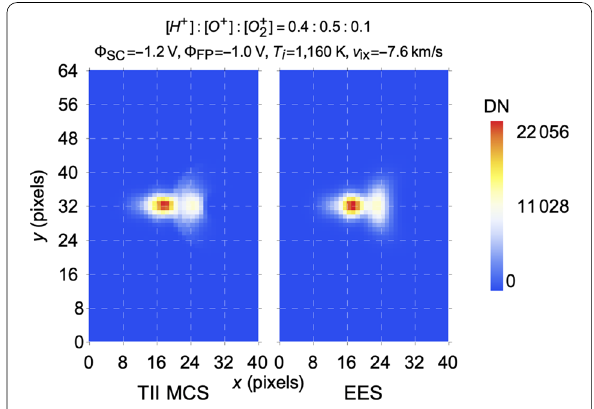
Fig. 21 TII MCS (left) and EES (right) model images for a 1160 K mixed ion population rammed at 7.6 km/s consisting of H + , O + and O + 2 in relative concentrations of 0.4, 0.5 and 0.1, respectively. A satellite floating potential of - 1.2 V was simulated with a faceplate voltage of - 1.0